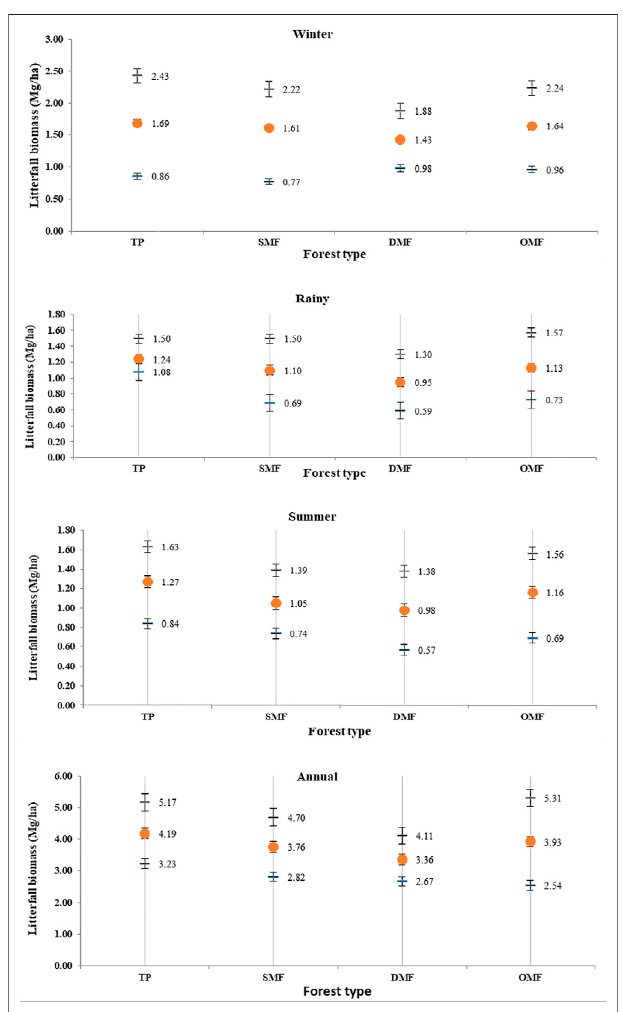
FIGURE 9 | Estimate annual litterfall biomass (Mg/ha) with 95% C.I. for TP, SMF, DMF and OMF forest types during 2016 – 18 for season.